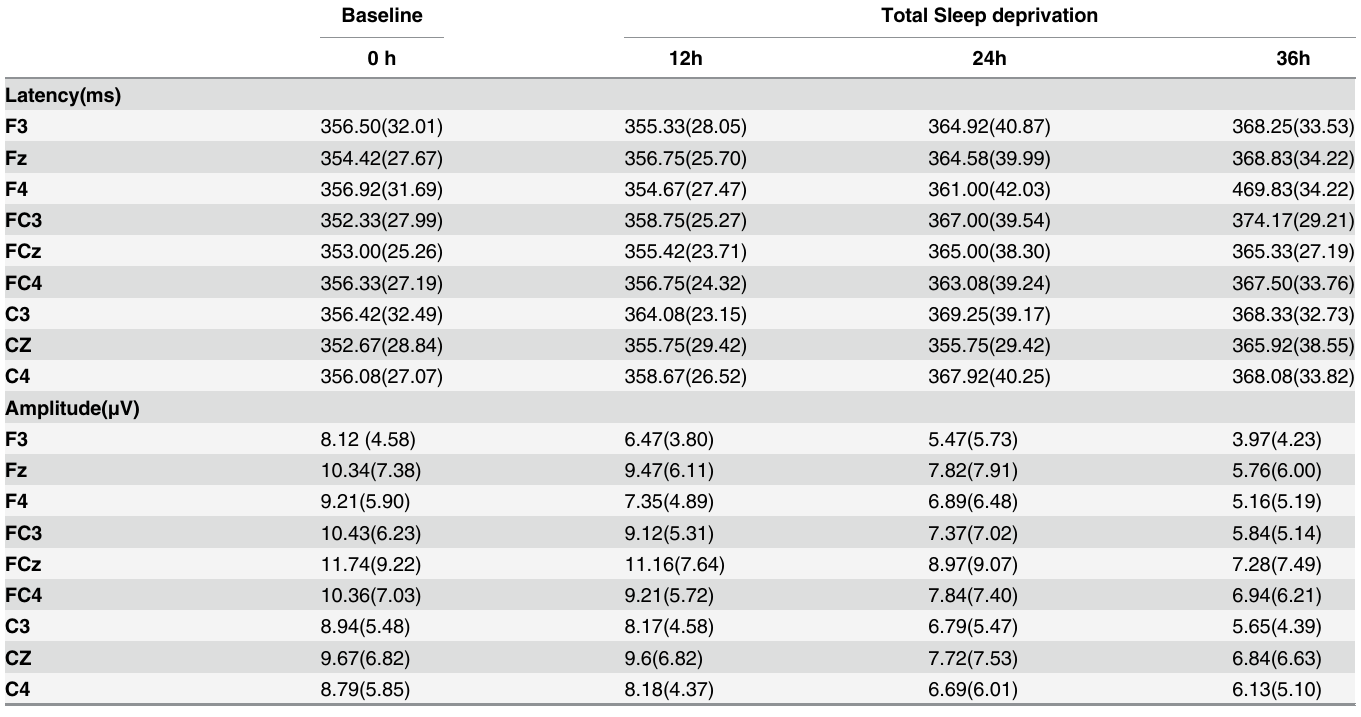
Table 3. Average NoGo-P3 Latencies and Amplitudes at F3, Fz, F4, FC3, FCz, FC4, C3, CZ, and C4 after Different Lengths of Total Sleep Deprivation.